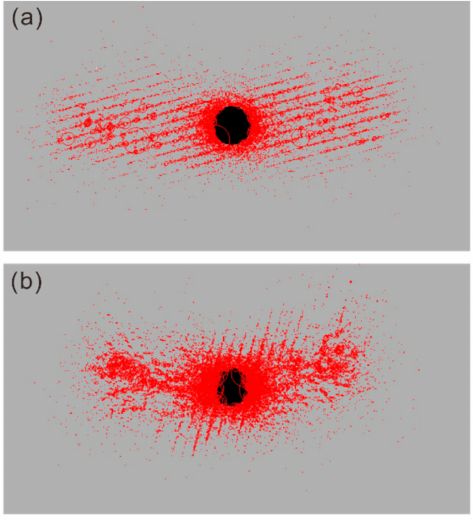
Figure 7. Distribution of simulated microseismic events (red circles) during hydraulic fracturing; the circle size indicates the microseismic event magnitude. The bedding orientations are 15 ◦ and 75 ◦ , and the boundary stress and injection rate were the same as for the base model. ( a ) Bedding orientation 15 ◦ ; ( b ) Bedding orientation 75 ◦